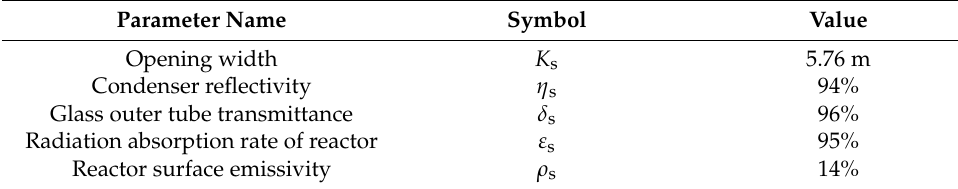
Table 1. Main design parameters of ET-100 collector [36].